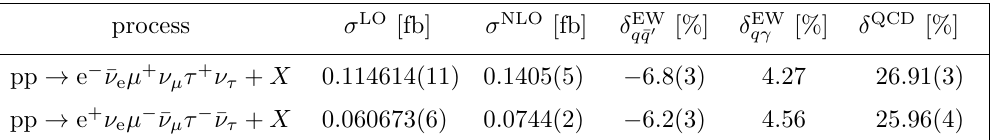
Table 4. LO and NLO cross section, (cid:27) LO and (cid:27) NLO , and relative corrections (cid:14) EW (cid:14) QCD for proton-proton collision at a CM energy of cut (4.13) on the transverse momentum of the leading lepton. Monte Carlo integration errors are given in